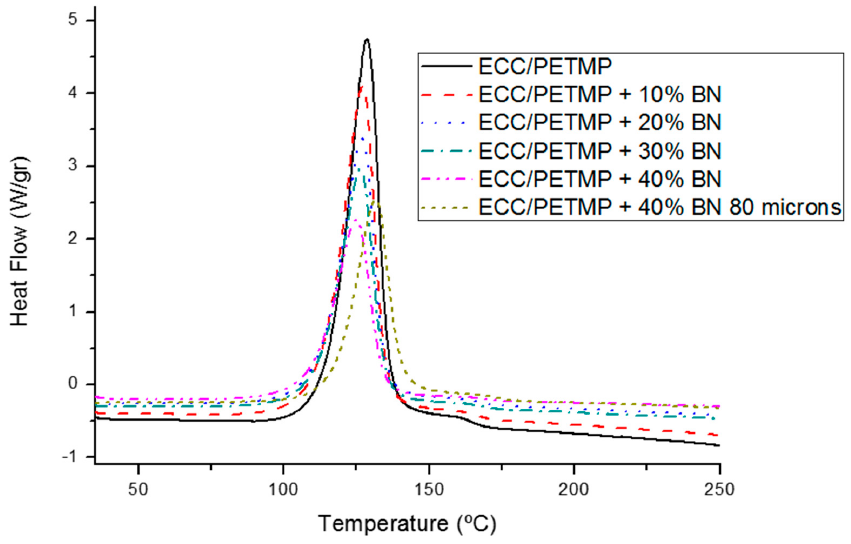
Figure 1. DSC curves showing the effect of the addition of different proportions of BN in wt. % to the formulation. Table 1. Calorimetric data of formulations ECC/PETMP with several proportions of BN.